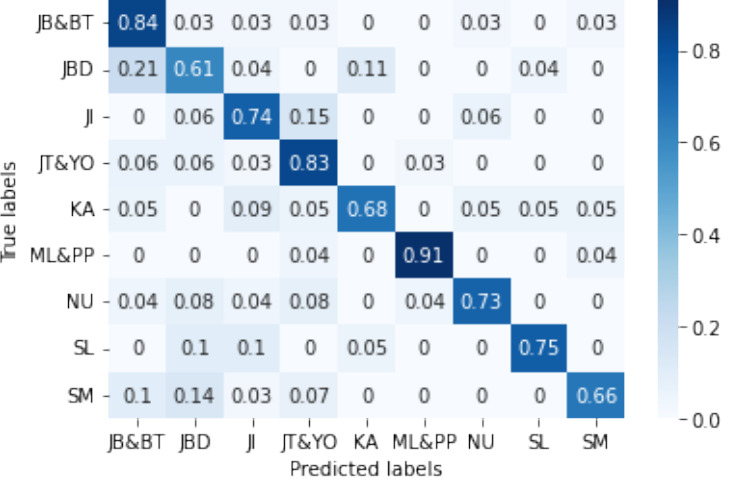
Figure 9. Confusion matrix obtained with the IndoBERT. The y-axis shows instances of the true class (i.e., the Twitter user’s home location), while the x-axis shows instances of the predicted class (i.e., the predicted home location). The values of the diagonal elements represent the ratio of correctly predicted classes. Therefore, confusion is expressed by off-diagonal misclassification because they were incorrectly classified as a different